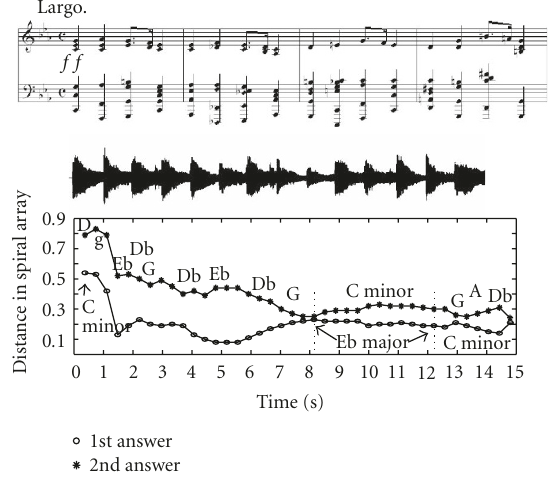
Figure 11: Key answers over time of sys(FA, CEG) on Chopin’s Pre- lude number 20 in C minor.